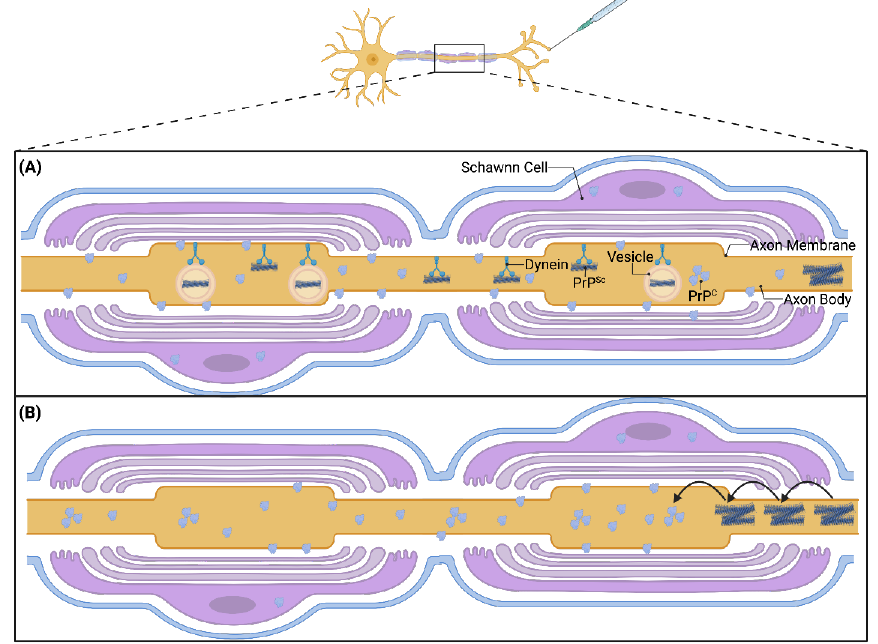
Figure 3. Prion Transport Mechanisms. Current theories of PrP Sc axonal transport after neuroinva-